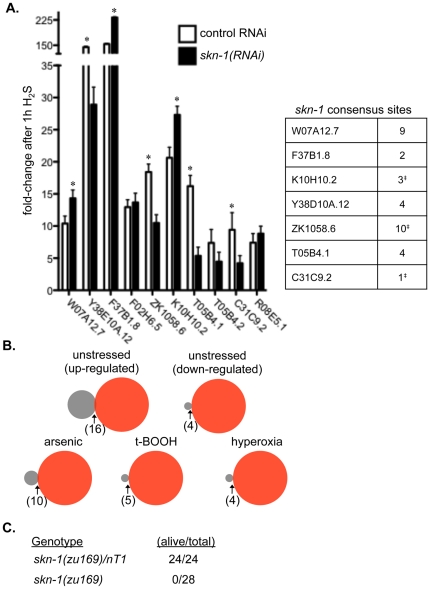
SKN-1 is essential for appropriate response to H2S.A. Some H2S-induced transcriptional changes require skn-1. Changes in mRNA abundance after 1 h exposure to H2S were measured by qRT-PCR in N2 animals grown on control RNAi food L4440 (open bars) or on skn-1(RNAi) (filled bars). Three biological replicates for each group were performed, and each PCR reaction was run in duplicate. Error bars represent the standard deviation of the biological replicates, propagated through the ΔΔCt and fold-change calculations. *Difference between induction in control is significantly different than skn-1(RNAi) p<0.05. Table shows the frequency that core skn-1 consensus sites (RTACT, [27]) are found within the upstream 2 kb flanking region of each transcript whose regulation in response to H2S was altered by skn-1(RNAi). ‡genes reported to have SKN-1 bound in the promoter in the ModENCODE database [38]. B. There is little similarity between response to H2S and other skn-1-dependent transcriptional responses. The overlap between the H2S-regulated genes after 12 h (n = 445) was greater than chance when compared with skn-1-dependent gene products in unstressed conditions (n = 233, 16 common transcripts, hypergeometric probability 0.006) and for genes that require skn-1 for arsenic-induced upregulation (n = 118, 10 common transcripts, hypergeometric probability 0.01) [27]. There was not significant overlap between transcripts altered by exposure to H2S and skn-1 dependent transcripts that are downregulated in unstressed conditions (n = 63, hypergeometric probability 0.13), upregulated by tert-butyl hydroperoxide (n = 64, hypergeometric probability 0.06) or hyperoxia (n = 68, hypergeometric probability 0.15). C. skn-1 is required to survive exposure to H2S. Unc animals (skn-1/nT1 heterozygotes) were compared to non-Unc, skn-1 homozygotes for sensitivity to H2S (#animals alive/total after exposure to 50 ppm H2S).